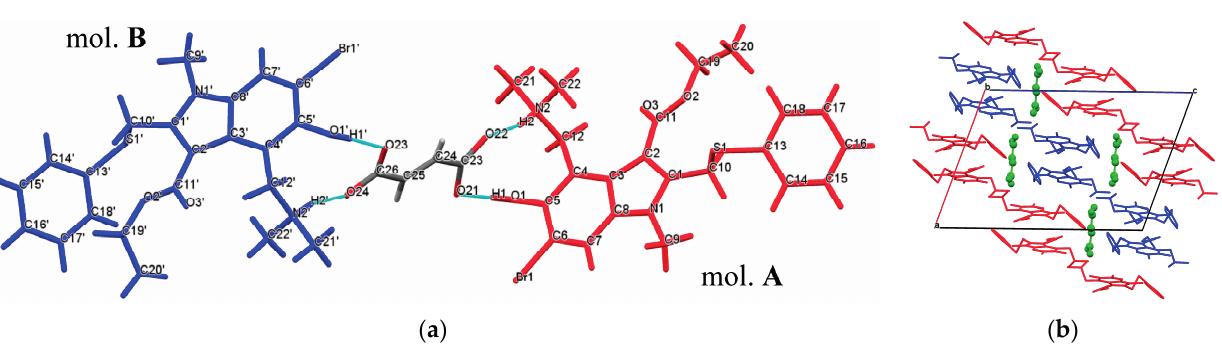
Figure 3. ( a ) Hydrogen bonded trimeric molecular unit in the [ Arb + Fum ] crystal, A and B denote two conformationally distinct cations of arbidol; ( b ) packing organization of [ Arb + Fum ]. The layers of conformationally distinct Arb molecules are shown in red and blue colors. Fumaric acid molecules are colored in green. H atoms are omitted.